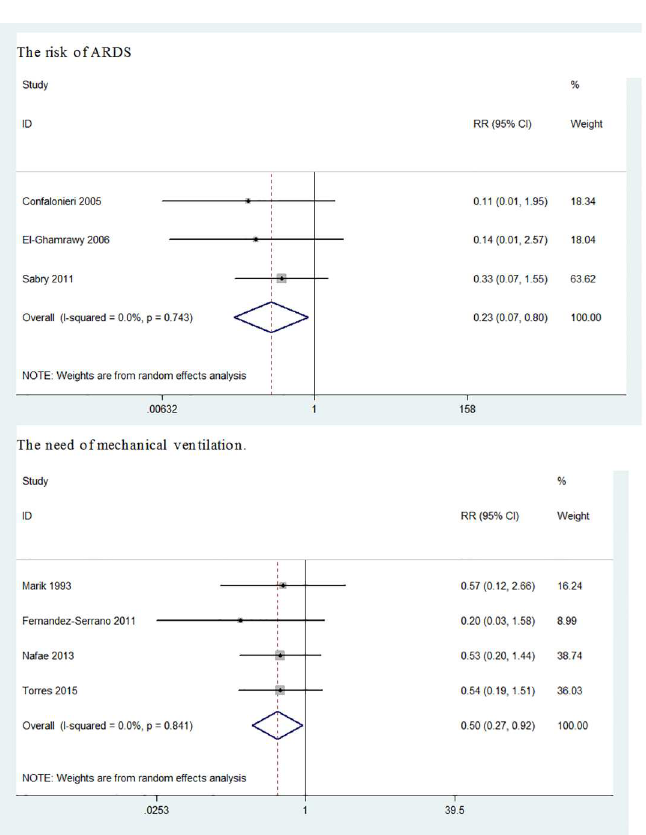
Fig 6. Effect of corticosteroids on development of ARDS and need for mechanical ventilation in patients hospitalized with severeCAP.